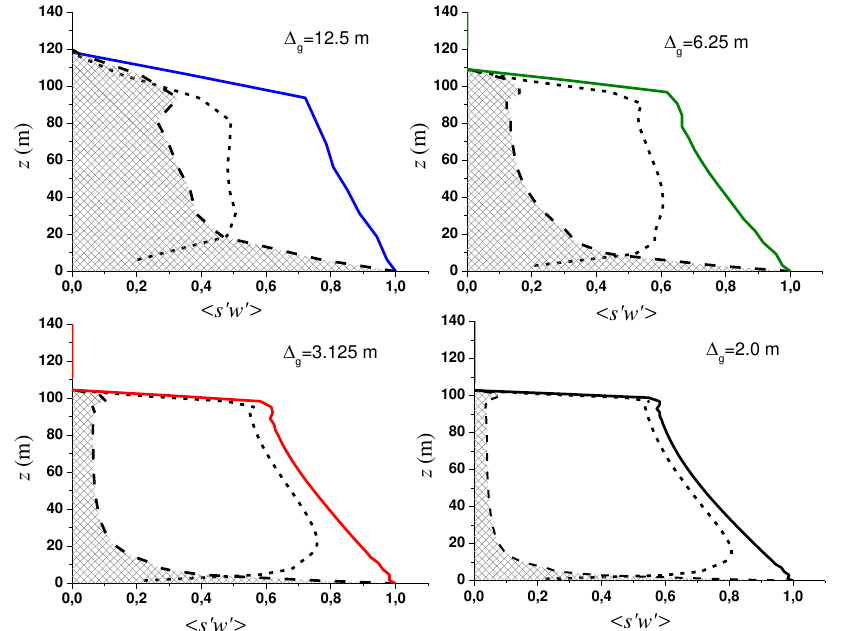
(cid:11) (solid lines), resolved F res 3